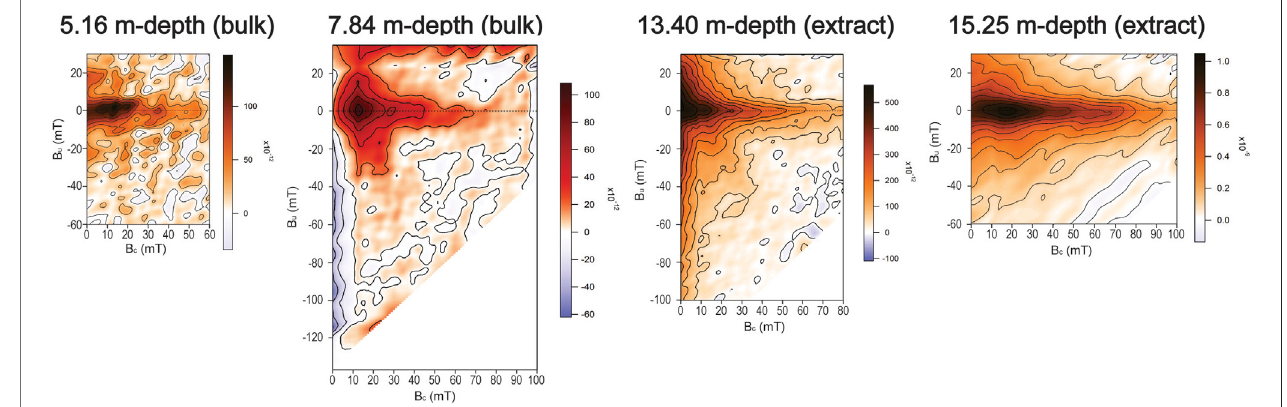
FIGURE 10 | First-order reversal curve (FORC) diagrams for four subsamples at different